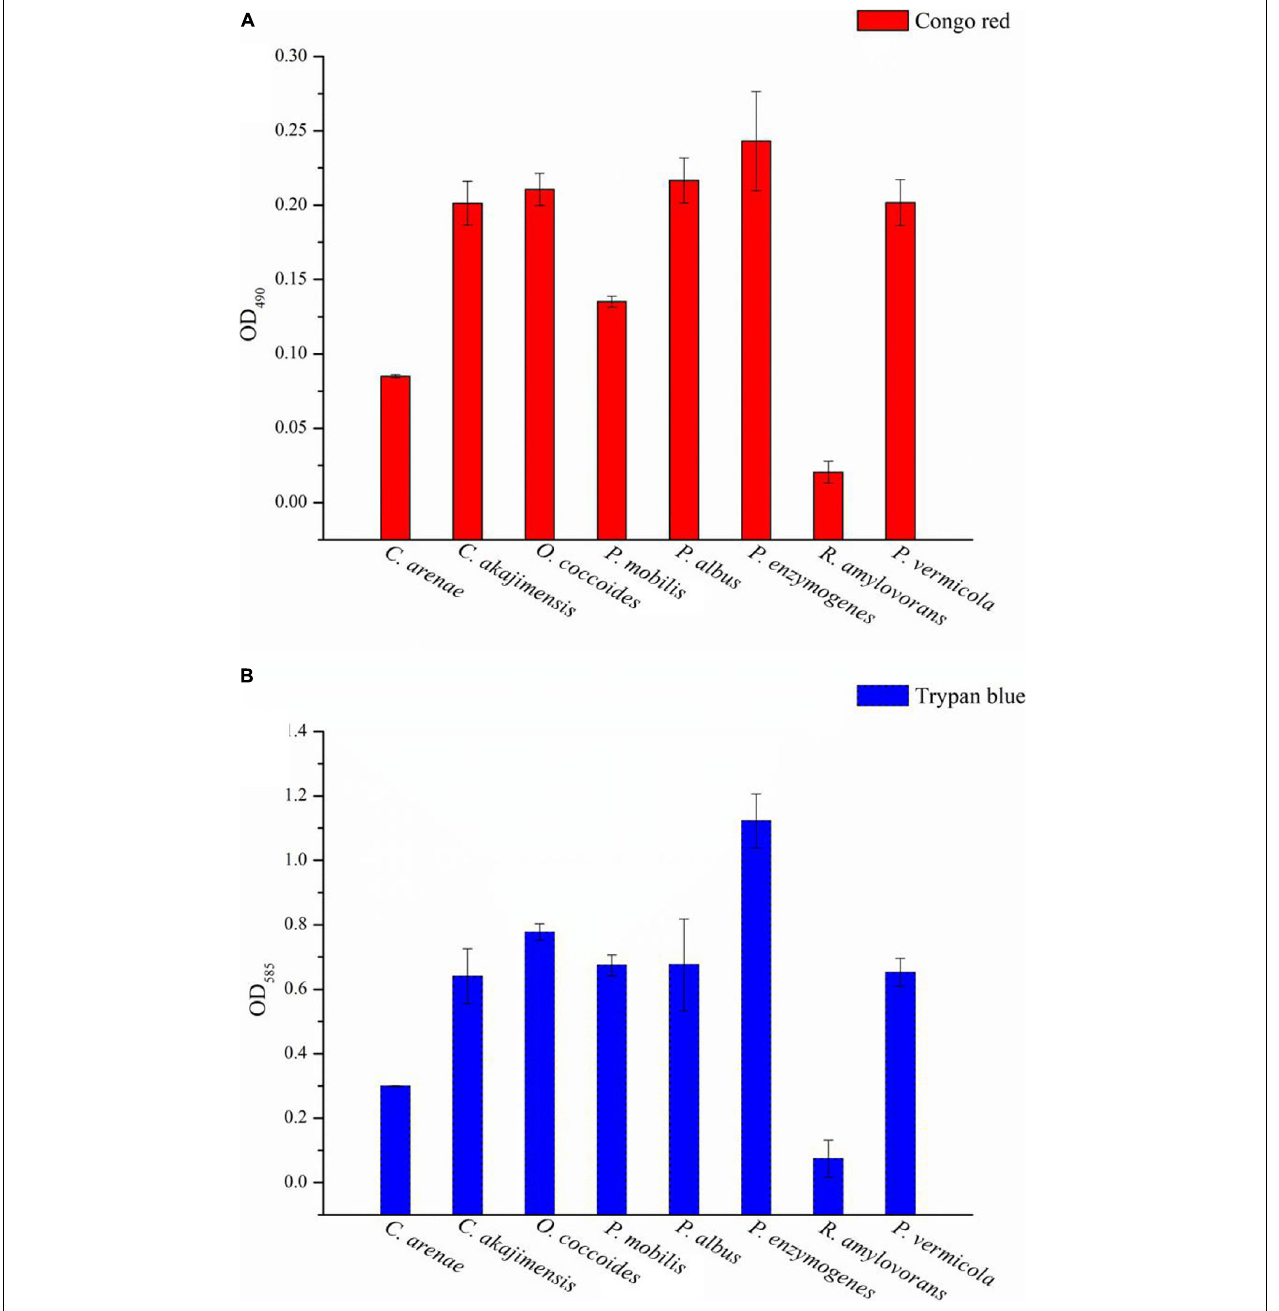
FIGURE 3 | The EPS content of the type species strains of Puniceicoccaceae was assayed with Congo red and Trypan blue staining. Y -axis: all group data minus the optical densities (OD) of the control. The higher the value, the higher the EPS content of the strains. X-axis: the Latin name of strains. Congo red and Trypan blue are the name of the dye